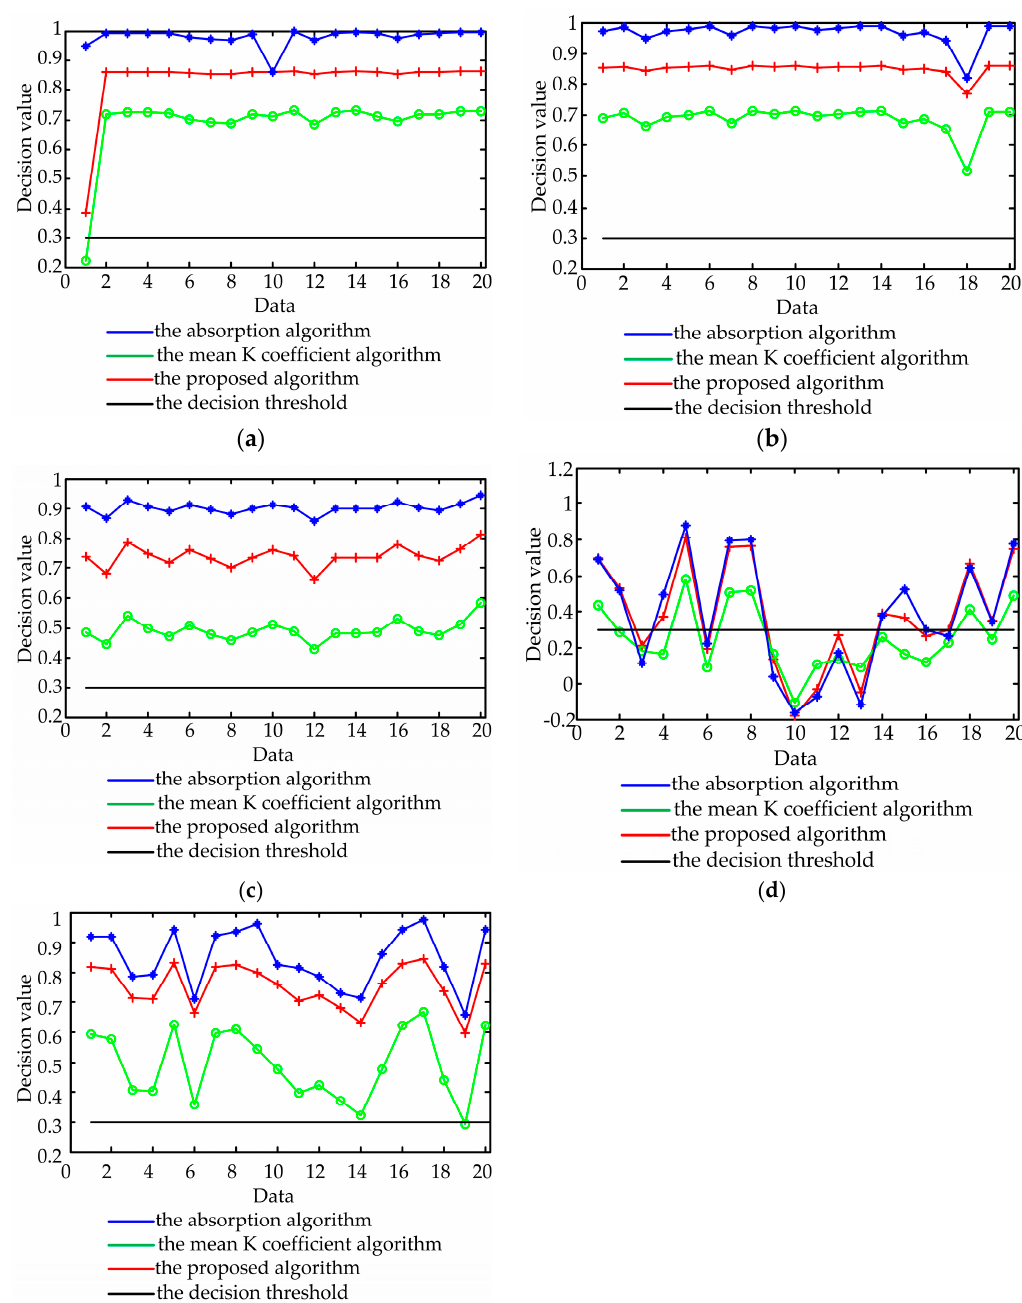
Figure 13. Comparison of the accuracy rate of the 3 improved algorithms. ( a ) data for the inner ring fault at 9 Hz; ( b ) data for the inner ring fault at 7.5 Hz; ( c ) data for the outer ring fault at 9 Hz; ( d ) data for the outer ring fault at 7.5 Hz; ( e ) data for the rolling element fault at 9 Hz.